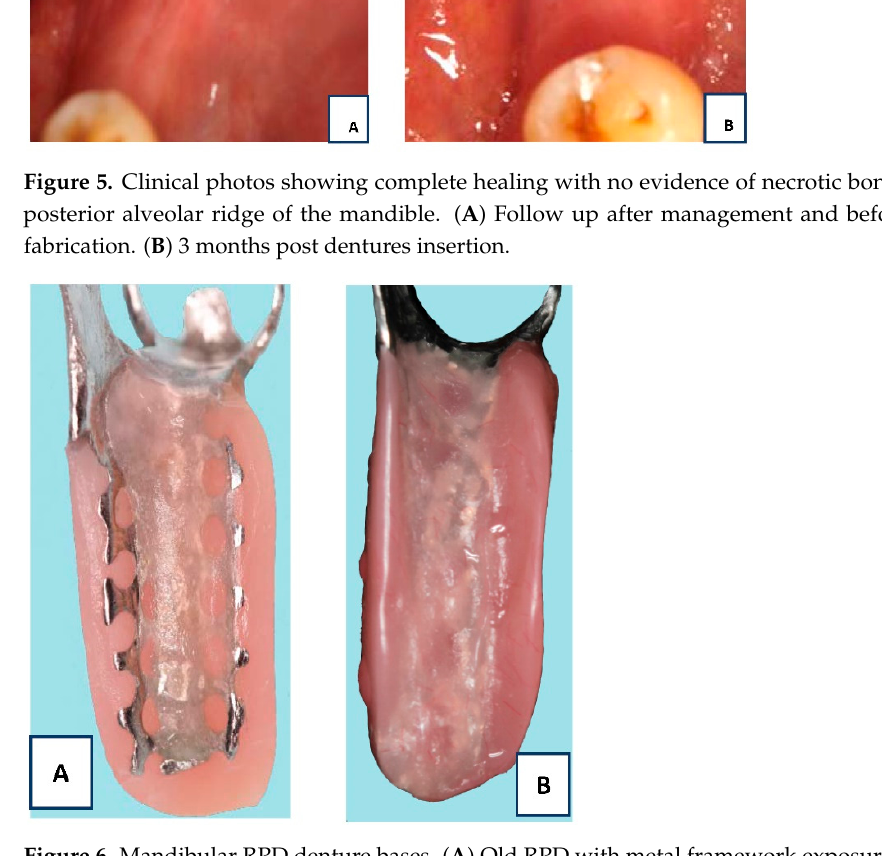
Figure 6. Mandibular RPD denture bases. ( A ) Old RPD with metal framework exposure. ( B ) Newly fabricated RPD with proper denture base extension and acrylic thickness.